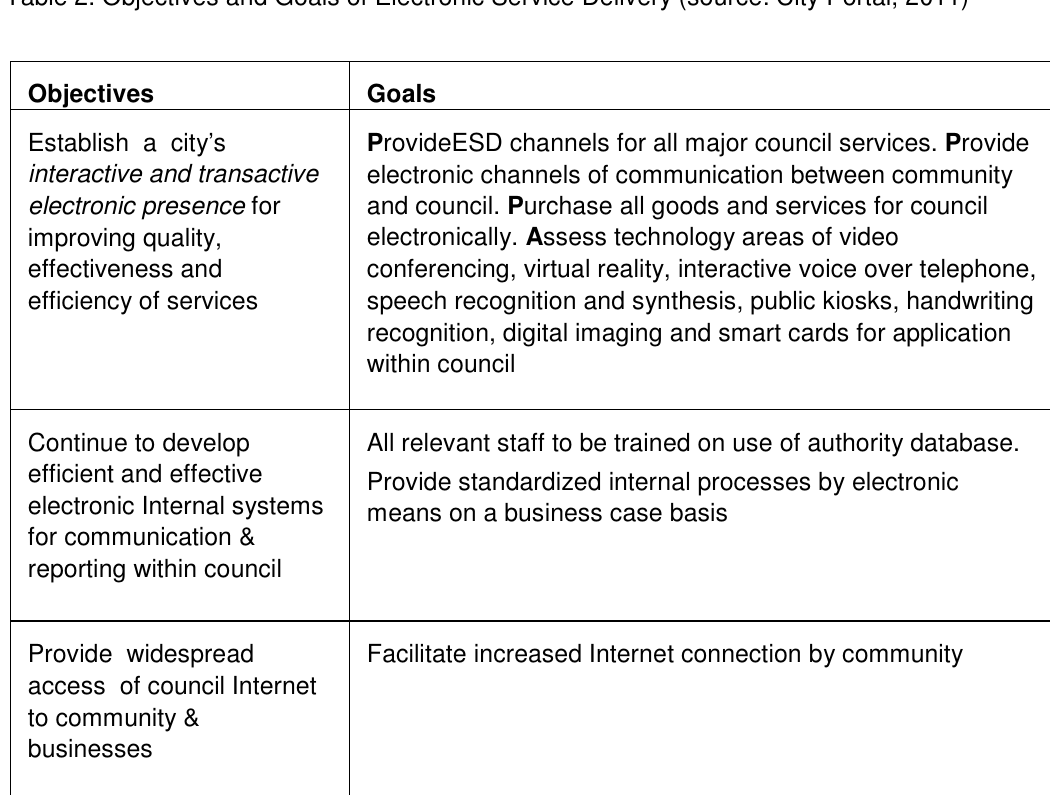
Table 2. Objectives and Goals of Electronic Service Delivery (source: City Portal, 2011)